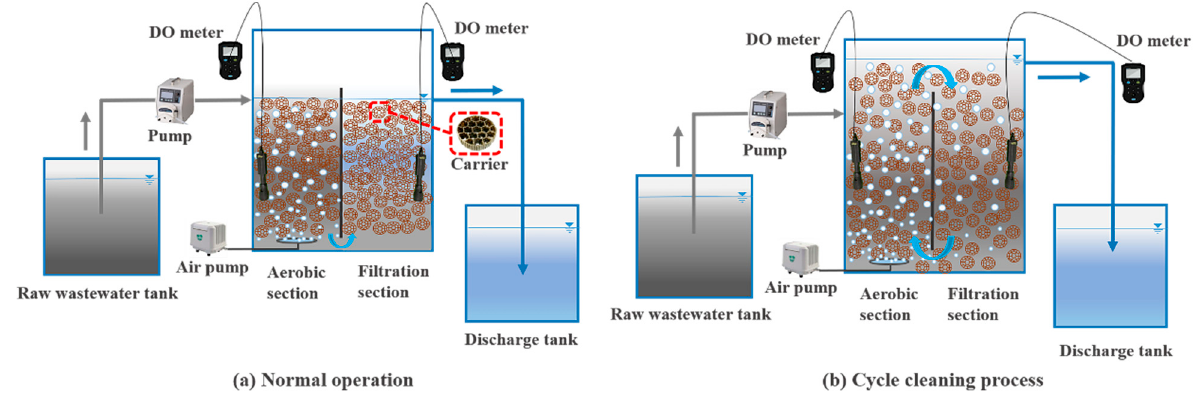
Figure 1. Schematic diagram of the highly packed biofilm reactor (HPBR) under ( a ) normal operation and ( b ) cycle cleaning process.